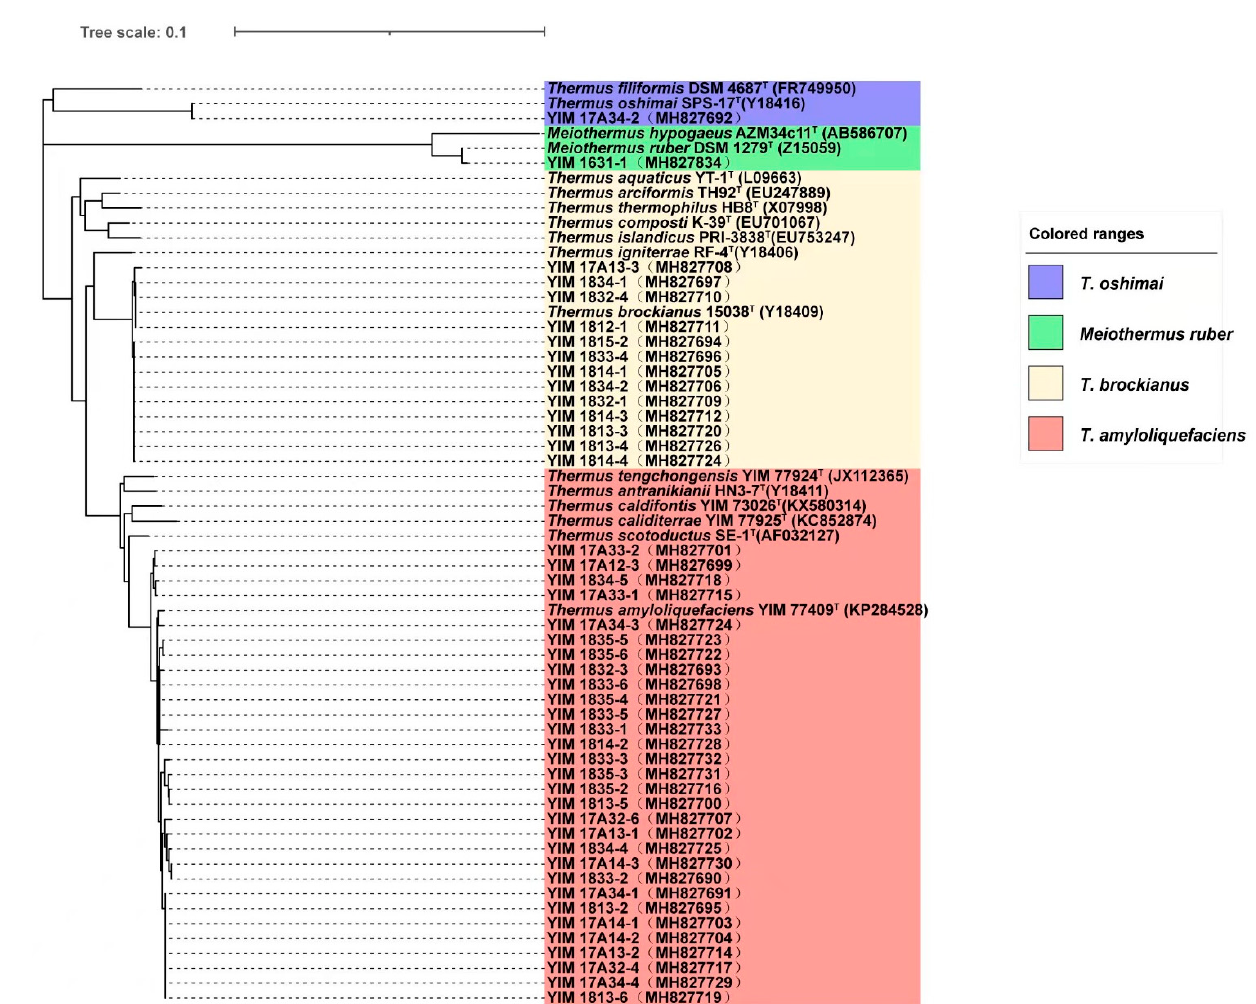
Figure 4. The phylogenetic tree for the culturable Thermus strains in the Dali geothermal region. Numbers at nodes indicate bootstrap values (>50%) based on a neighbor-joining analysis of 1000 resampled datasets. The vertical scale bar in the middle represents 0.1 substitutions per nucleotide position.